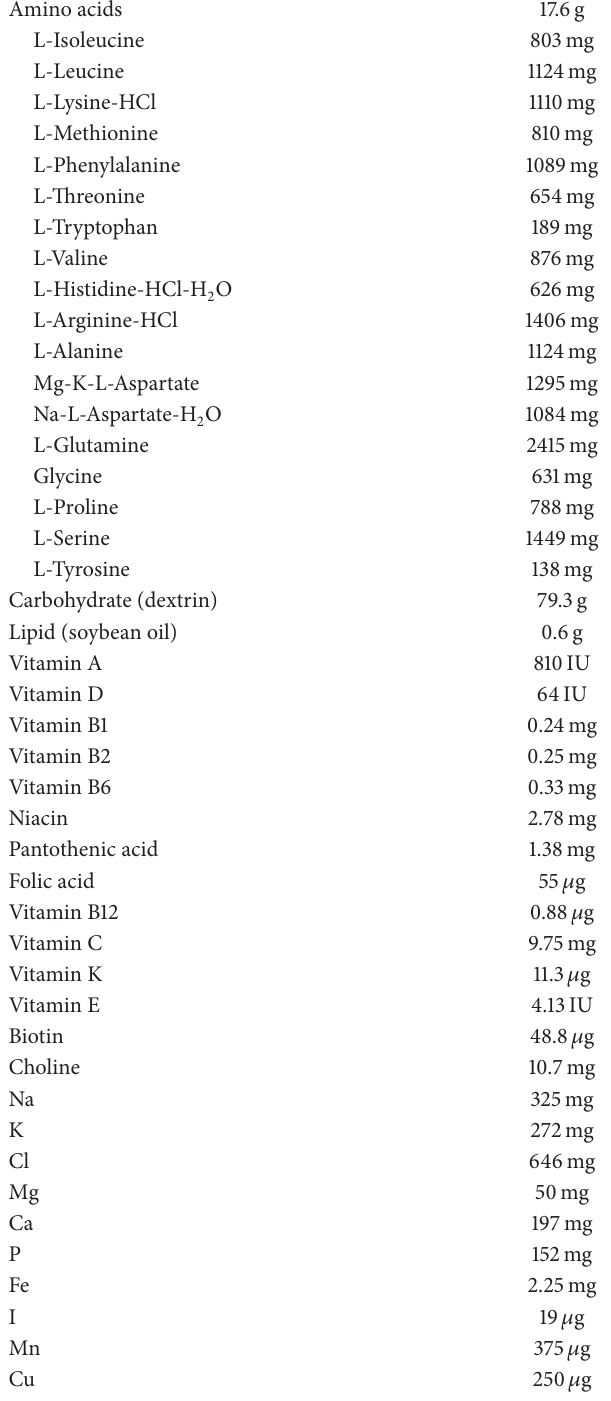
Table 1: Ingredients of Elental (total 100